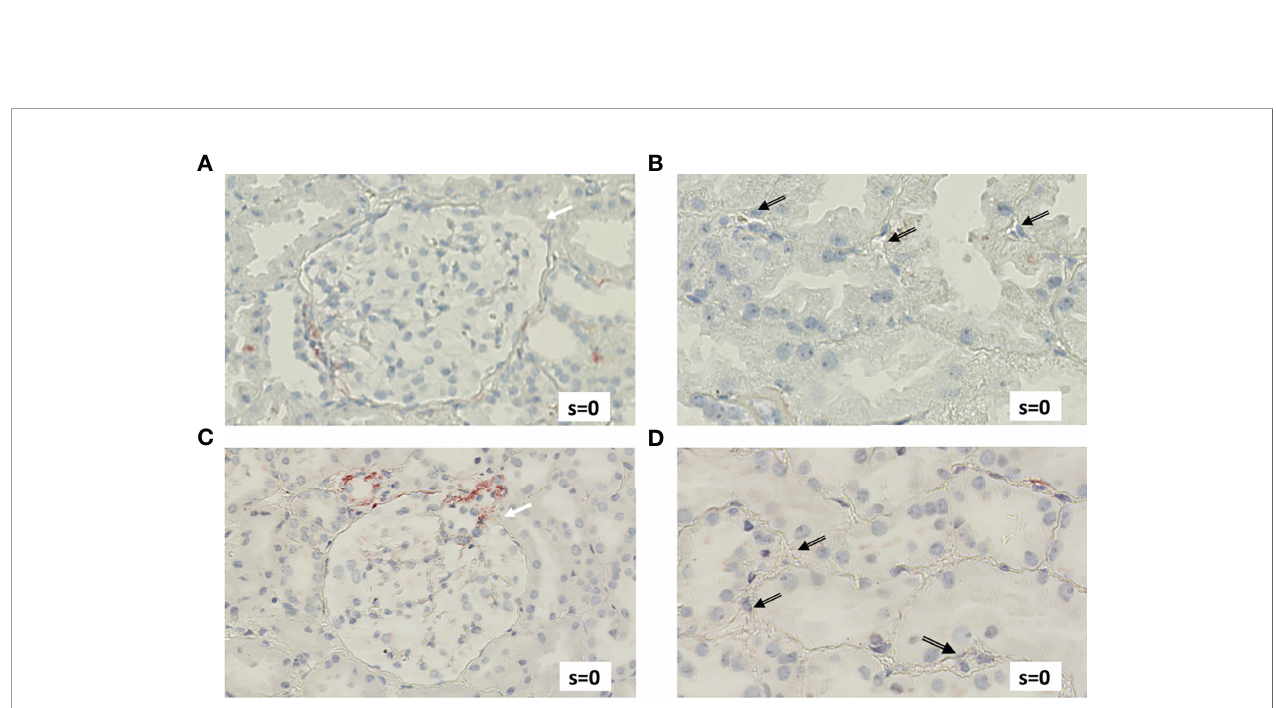
FIGURE 6 | Renal biopsy staining for complement factors in a KTR without indication for undergoing biopsy and without signs of rejection in biopsy (NR patient). Selected section of biopsy slide stained for C3d in glomeruli (A) and in peritubular capillaries (B) . Selected section of biopsy slide stained for C5b-9 in glomeruli (C) and in peritubular capillaries (D) . White arrows indicate glomeruli and black arrows indicate peritubular capillaries. Semi-quantitative scores (0-4) are indicated in the lower right corner of each picture. KTR, kidney transplant recipients; s, semi-quantitative